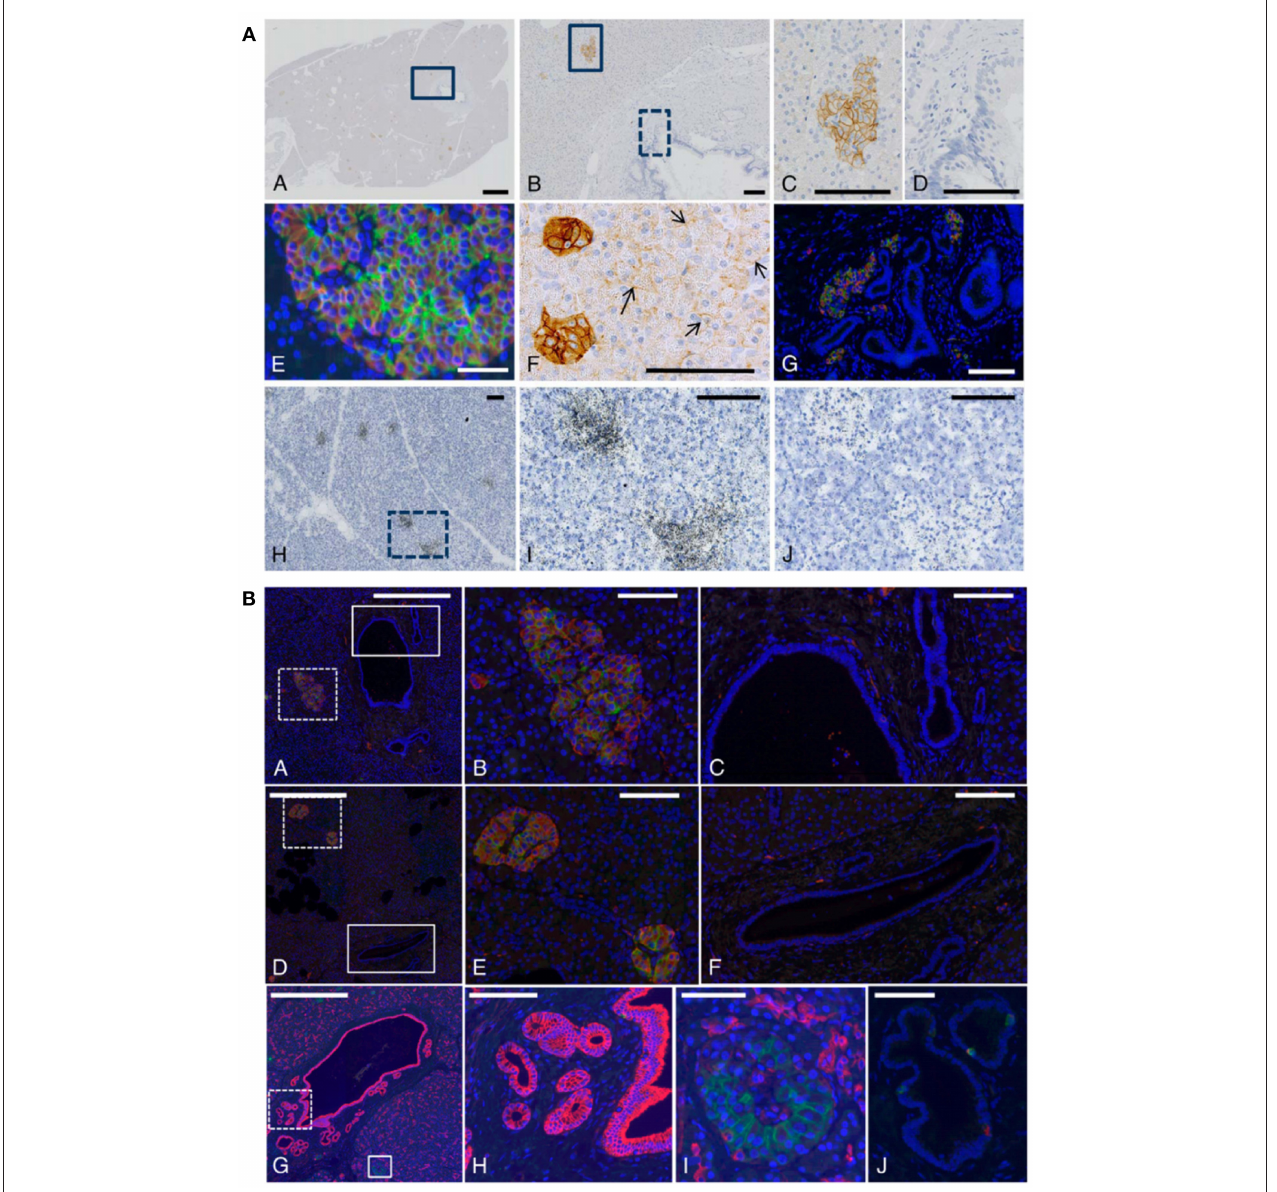
FIGURE 5 | GLP-1 receptor immunoreactivity using monoclonal antibody 3F52 on monkey and human pancreas. (A) GLP-1R IHC with antibody MAb 3F52 on paraffin-embedded monkey pancreas (A–G) and ISLB with 125 I-GLP-1 on a frozen section from monkey pancreas (H–J). (B,C) Magnifications of solid-line boxed areas in (A,B), respectively. (D) High magnification of the dashed-line boxed area in (B). (I) High magnification of the boxed area in (H). (A–D,F) GLP-1R immunoreactivity using a DAB IHC protocol. (E,G) Images from a double-labeling GLP-1R insulin IHC fluorescence protocol. In (E), double labeling for GLP-1R (green) and insulin (red) shows complete co-localization, demonstrating that all GLP-1R–positive cells are beta-cells. The ductal epithelium is negative for GLP-1R (D). In (F), weakly GLP-1R–immunopositive acinar cells (arrows) can be seen adjacent to strongly staining islets (left). (G) High-magnification image of the main duct area of a cynomolgus monkey pancreas double-immunostained for GLP-1R (green) and insulin (red). (J) Image from the section adjacent to (I) and incubated with 125 I-GLP-1 plus an excess of unlabeled GLP-1. Scale bars correspond to 1mm (A) and 100 µ m (B–J). (B) A normal (A–C,G–J) and a diabetic (D–F) human pancreas double labeled for GLP-1R (green) and insulin (red). (B,E) High magnification images of the dashed-line boxes in (A,D), respectively. (C,F) High-magnification images of the solid-line boxes in (A,D), respectively. Note the complete co-localization of signals for GLP-1R and insulin in islets in (A,B,D,E) and absence of staining of ductal epithelium in (C,F). G-I, GLP-1R (green)/cytokeratin-19 (red) double staining in sample of normal human pancreas containing part of the main duct with PDGs. (G) Low-magnification overview. H, High magnification of area (dashed-line box in G) containing PDGs and showing no GLP-1R immunoreactivity. I, High magnification of area (solid line box in G) containing an islet with GLP-1R immunoreactive beta-cells. (J) Two GLP-1R/insulin-positive cells are located within the ductal epithelium. Scale bars correspond to 0.5mm (A,D,G), 100 µ m (B,C,E,F,H,J), and 50 µ m (I). DAB, diaminobenzidine; GLP-1R, glucagon-like peptide 1 receptor; IHC, immunohistochemistry; ISBL, in situ ligand binding; MAb, monoclonal antibody; PDGs, pancreatic duct glands. Reproduced with permission from Pyke et al. (73). By permission of Oxford University Press on behalf of the Endocrine Society, available at: https://academic.oup.com/endo/article/155/4/1280/2423090?searchresult=1. This figure is not included under the CC-BY license of this publication. For permissions, please contact journals.permissions@oup.com.